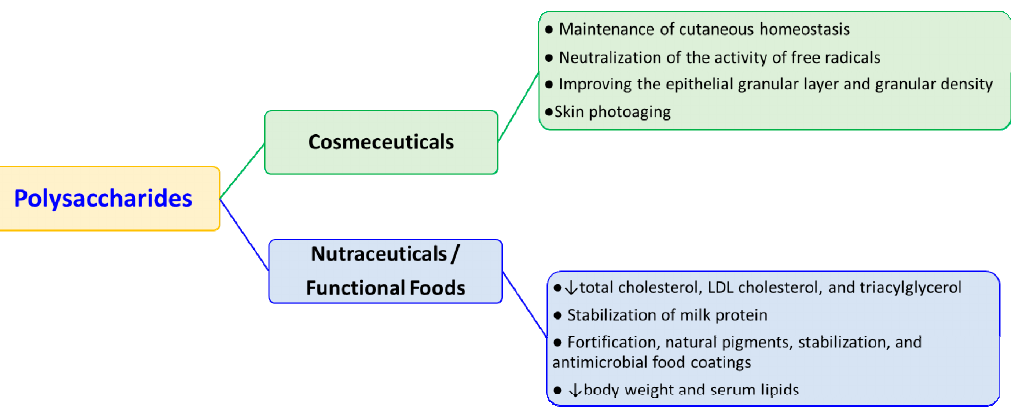
Figure 2. The cosmeceutical and nutraceutical applications of marine polysaccharides.